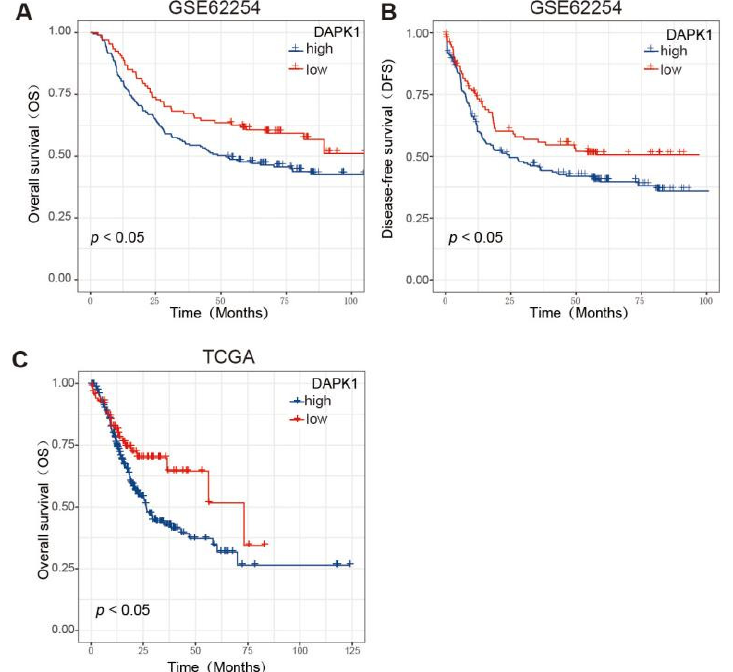
Figure 2. The prognosis of DAPK1 in GC patients. ( A ) Survival analysis of DAPK1 on the OS of GC patients based on the GSE62254 dataset; ( B ) survival analysis of DAPK1 on the DFS of GC patients based on the GSE62254 dataset; ( C ) survival analysis of DAPK1 on the OS of GC patients based on the TCGA dataset.